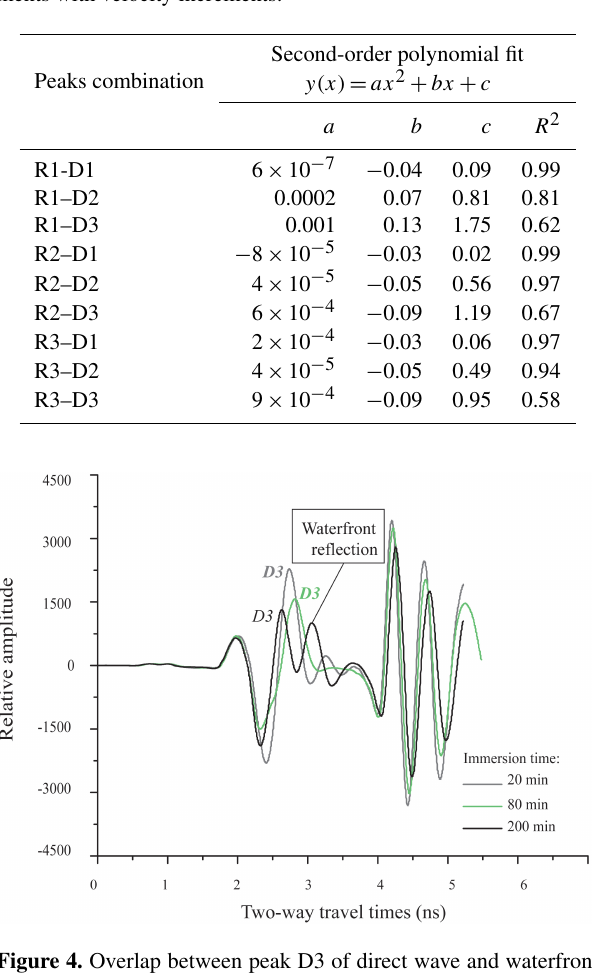
Table 1. Waterfront advance depth in centimeters and best adjust- ments with velocity increments.